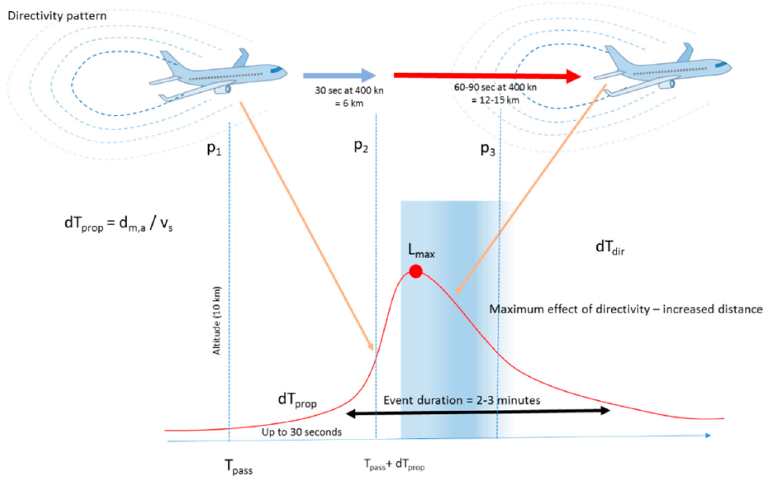
Figure 1. The propagation time of sound affects the correlating noise event significantly for high- altitude flights. At an altitude of 12 km, the event starts about 30 s after the closest point to the receiver. The directivity of the sound emission of the aircraft results in peak immission 60–90 s later. The aircraft can travel up to 20 km before the peak exposure